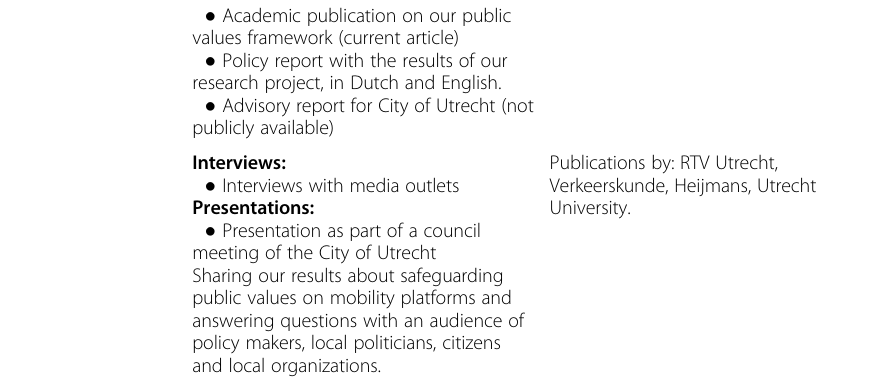
Table 4 Methodology: Overview of research activities and learning outcomes